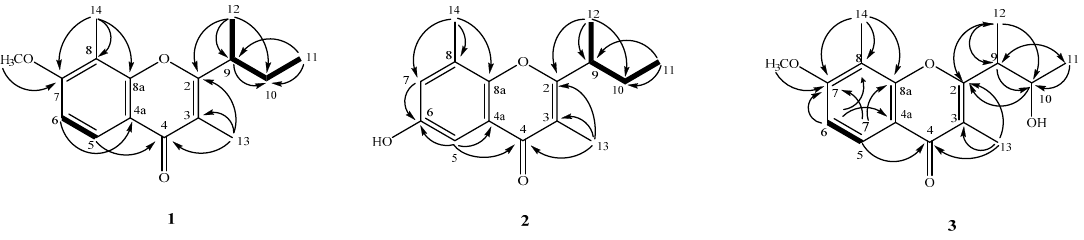
Figure 2. Key HMBC (H → C) and COSY (bold line) correlations for compounds 1 – 3 . Table 1. 1 H (400 MHz) and 13 C (100 MHz) NMR data of 1, 2 , and 5 (CDCl 3 ); 1 H (600 MHz) and 13 C